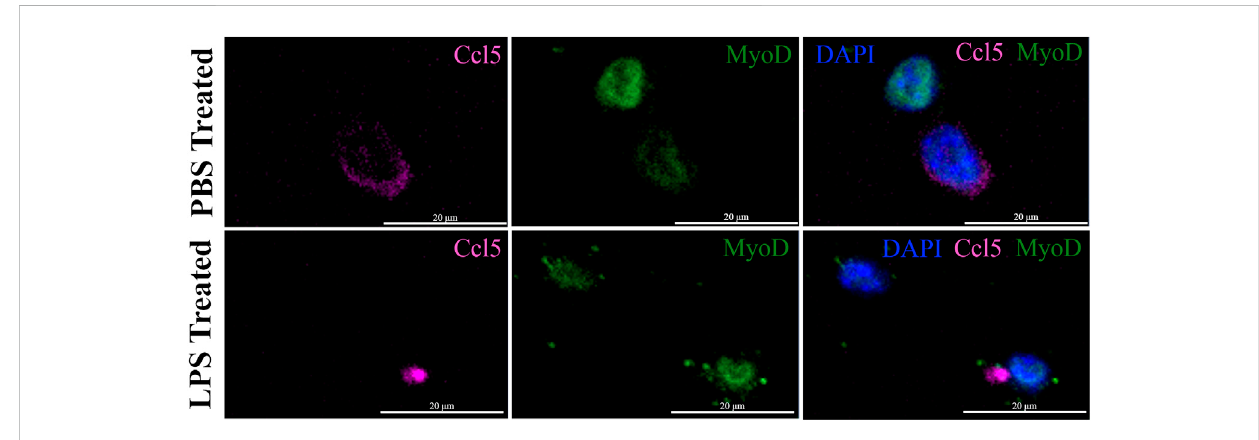
FIGURE 7 Co-expression of CCL5 and MYOD in proliferating MuSCs treated with LPS and PBS. The expression of CCL5 (magenta) and MYOD (green) was detectedbyindirectIFinMuSCstreatedwith LPS(1 mg/mL)orcontrol PBS,for 2 horcontrol PBStreatment. CCL5can bedetected inthecytoplasm and MYOD in the nucleus. The nuclei were visualized with DAPI (blue). Images were taken at ×20 magni fi cation. Scalebar = 20